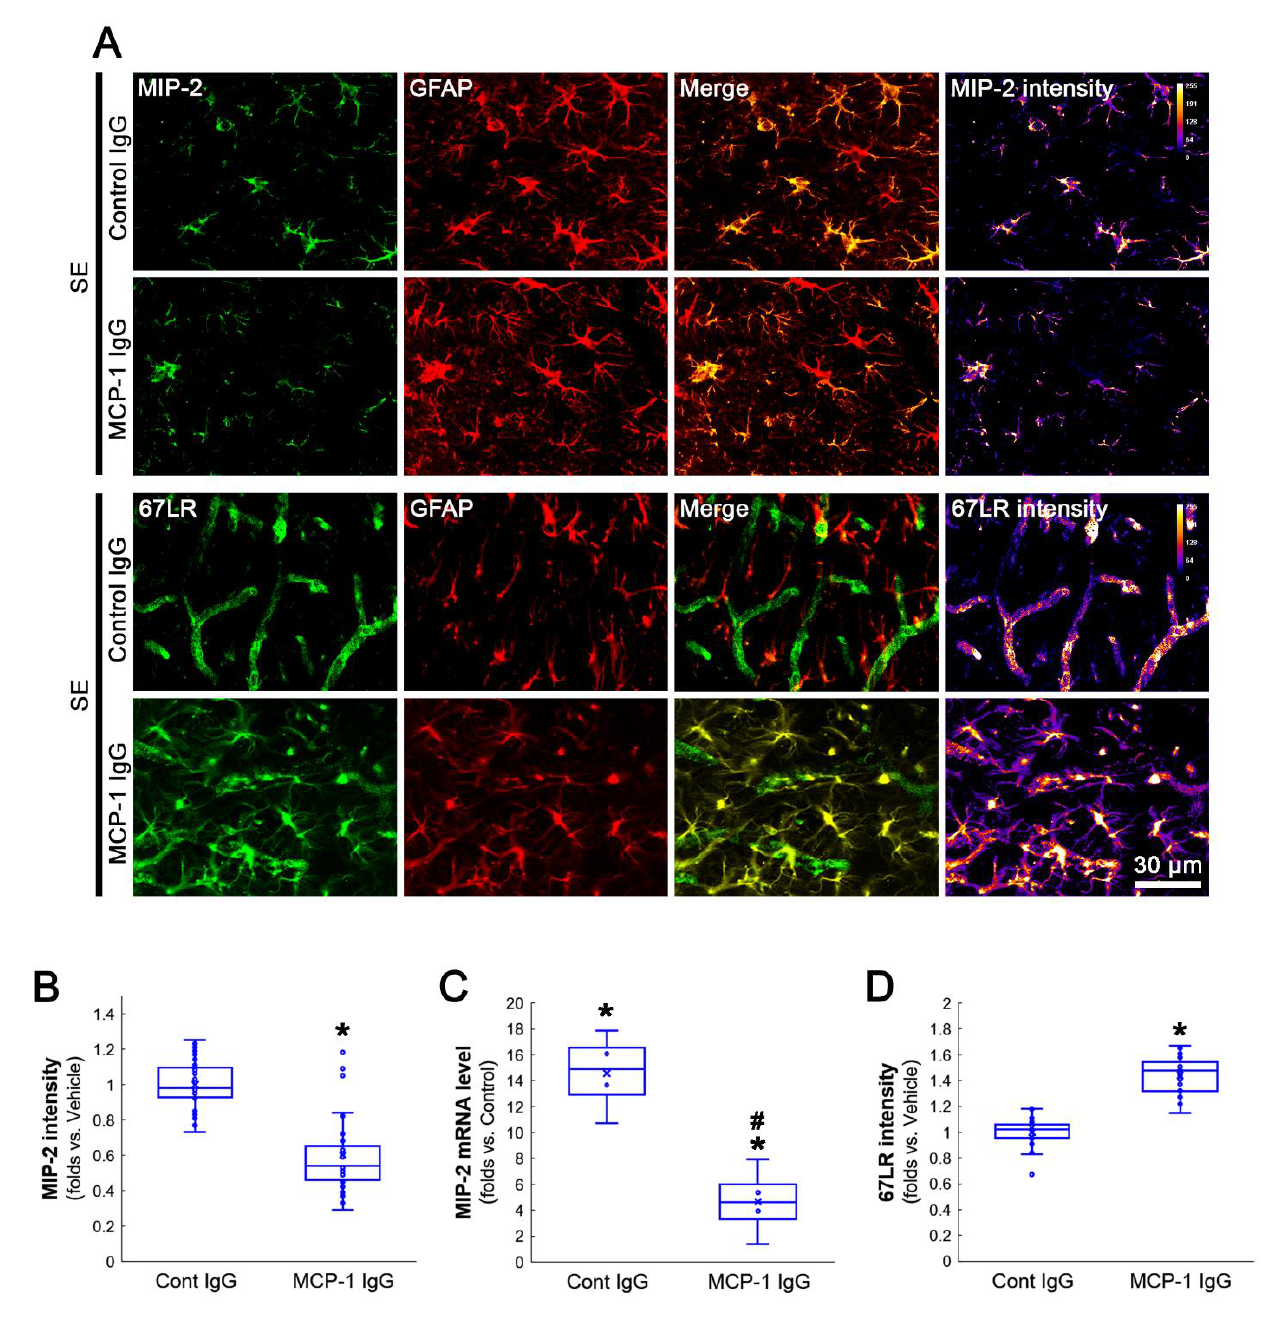
Figure 5. Effects of MCP-1 neutralization on MCP-1 induction and leukocyte infiltration in the FPC following SE. As compared to control IgG, MCP-1 neutralization attenuates leukocyte infiltration induced by SE. ( A ) Representative photos of MCP-1 expression and leukocyte infiltration in the FPC following SE. ( B ) Quantification of the MCP-1 intensity in microglia ( n = 40 cells in 7 rats, respec- tively). ( C ) Quantification of the number of infiltrating leukocytes. * p < 0.05 vs. control IgG ( n = 7 rats, respectively).